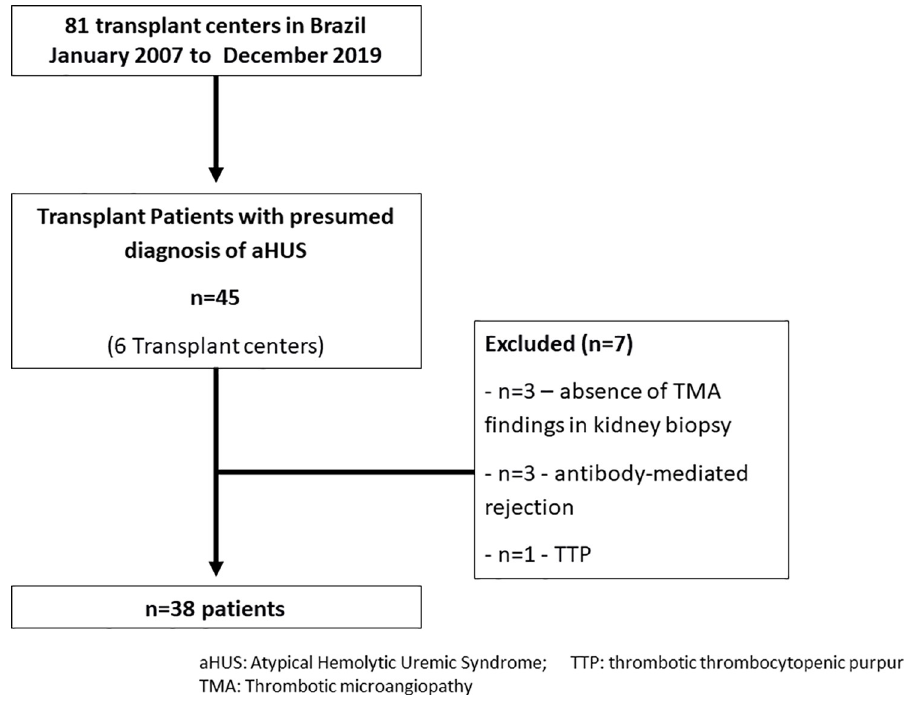
Fig 1. Flowchart